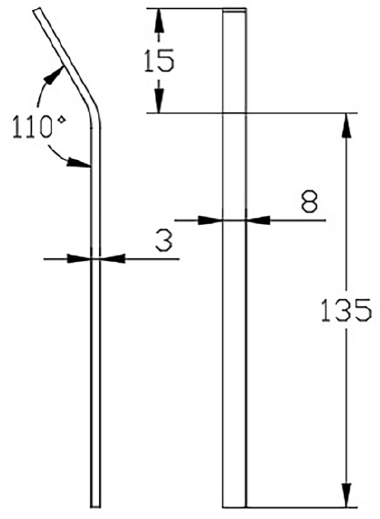
Figure 3. Geometric parameters of the elastic tooth .